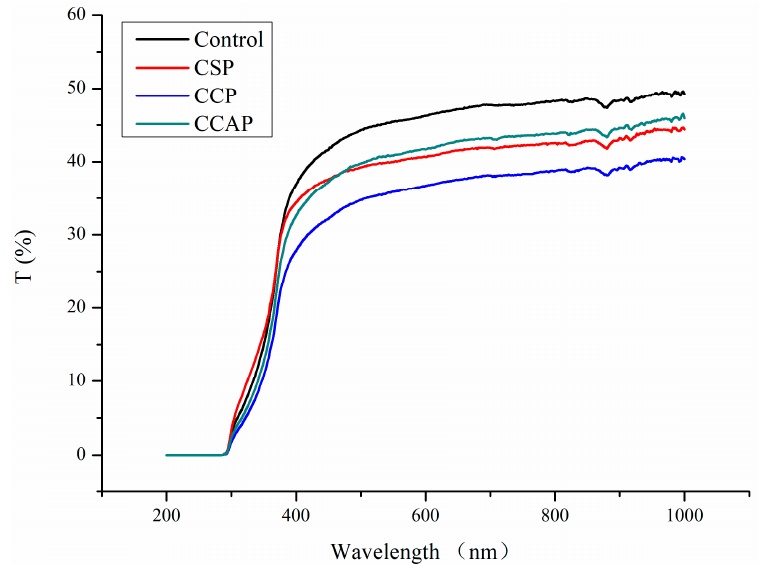
Figure 2. Light transmission of chitosan (control) and peptide − containing films. CSP: films from chitosan and soy protein peptides; CCP: films from chitosan and corn protein peptides; CCAP: films from chitosan and casein peptides.